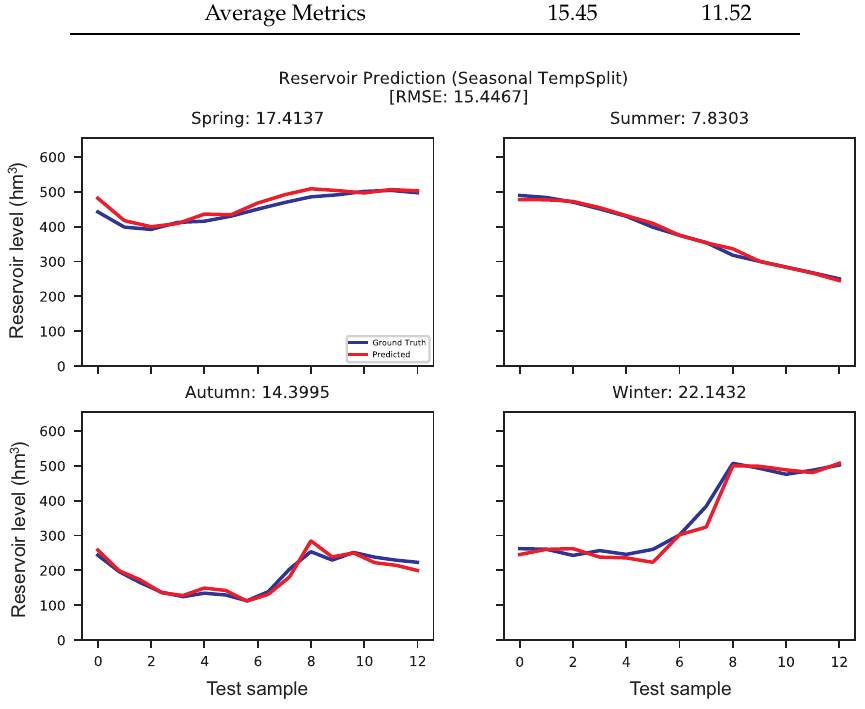
Figure 11. Ground truth vs. predicted for seasonal data, temporal partitioning